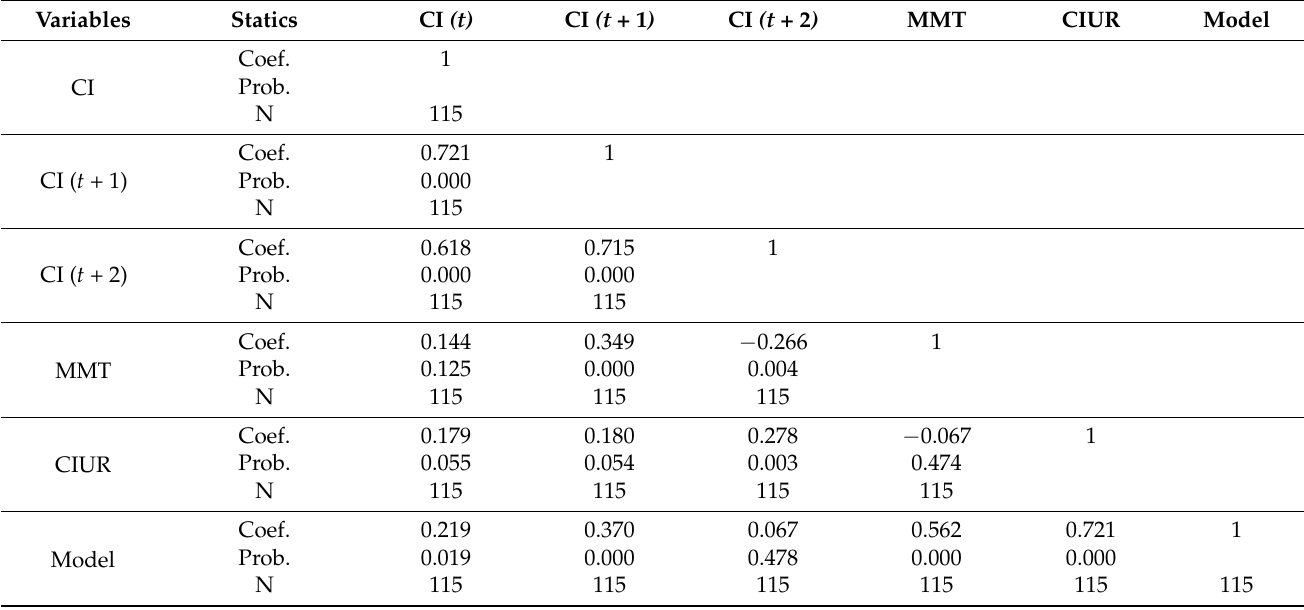
Table 3. Correlation of Crisis Prediction Model Variables.